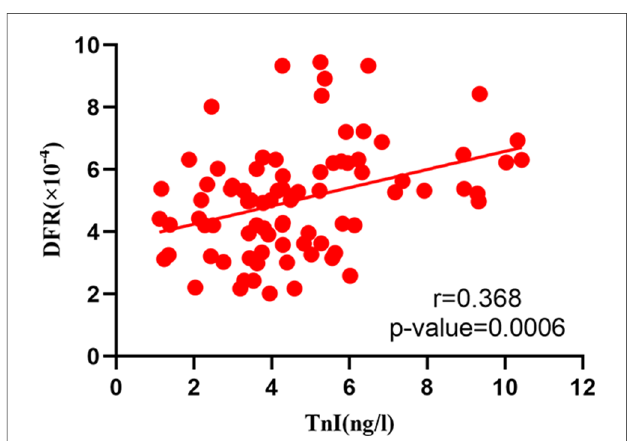
FIGURE 2 Correlation between serum BNP and DFR before operation.